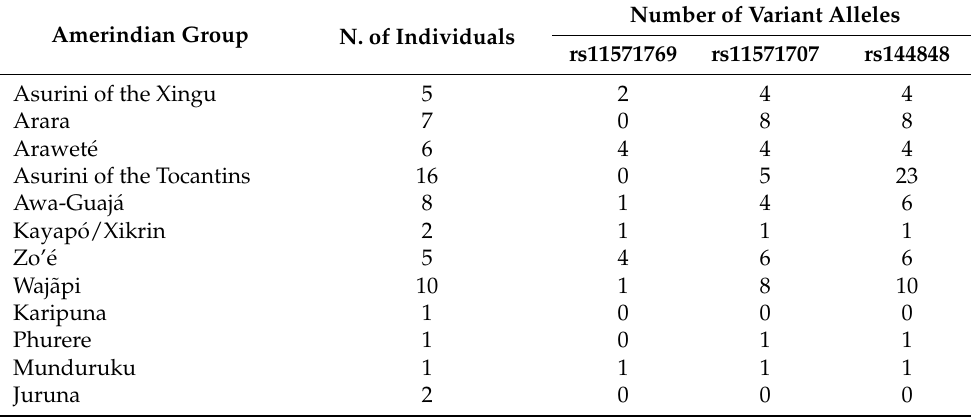
Table 3. The distribution of mutant alleles among the indigenous groups. Amerindian Group N. of Individuals